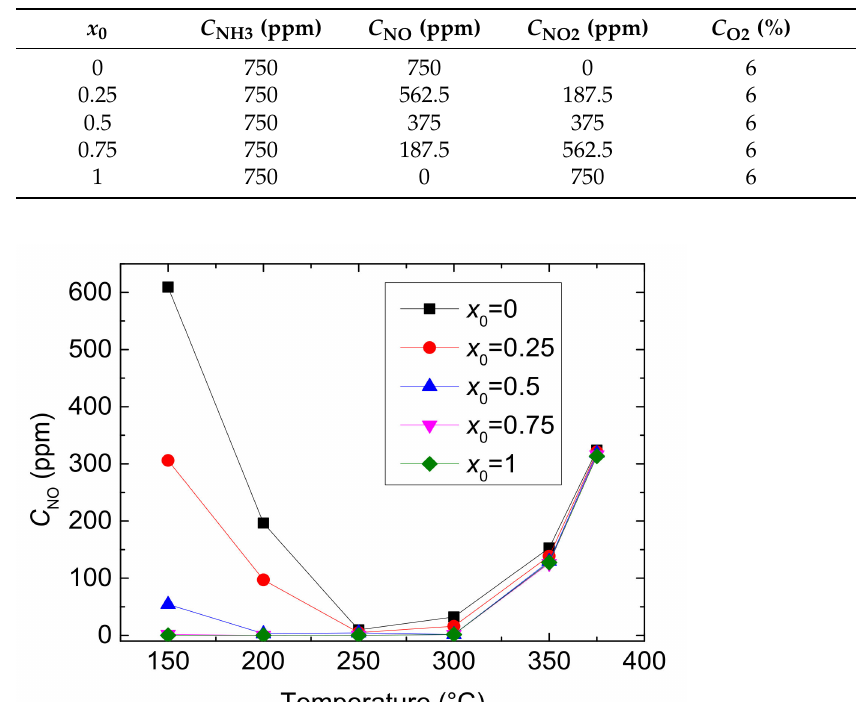
Table 1. x 0 and the corresponding inlet concentrations of components used for simulation.